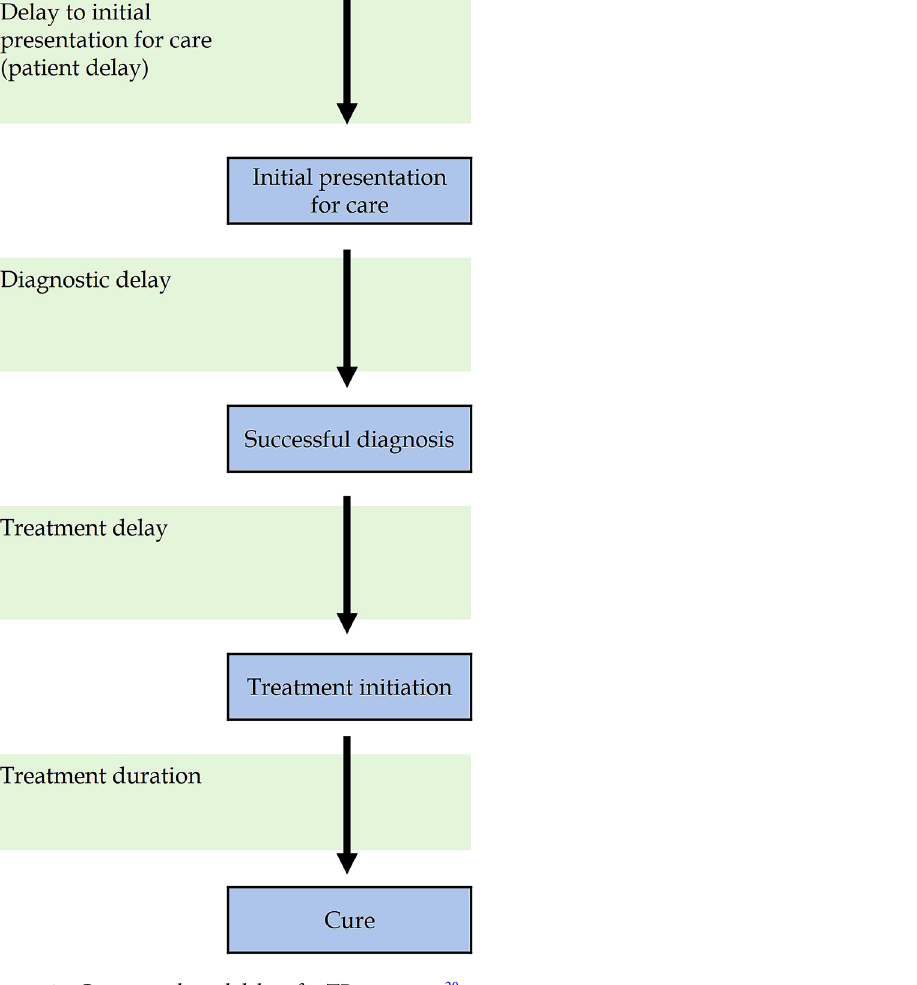
Figure 1. Care cascade and delays for TB treatment 20